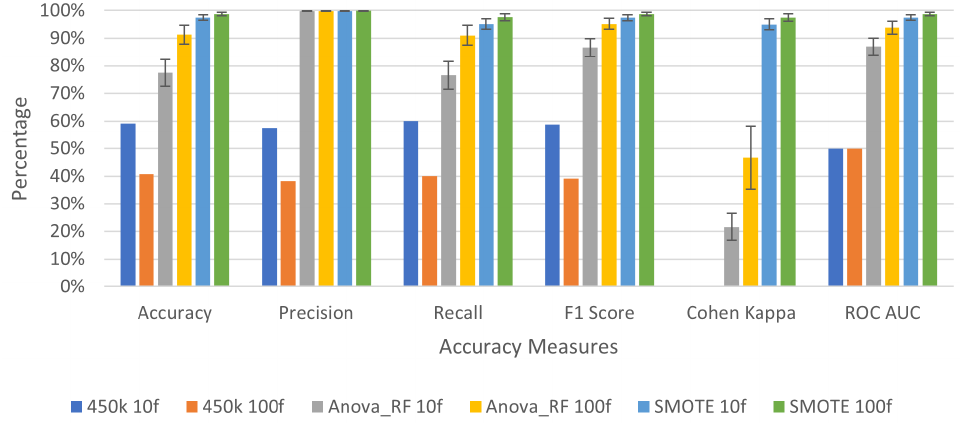
Figure 5. Accuracy metrics from deep learning models on 450K datasets before and after SMOTE application using validation split of 30%. These graphs have been derived from average accuracy values of five trials shown in Table